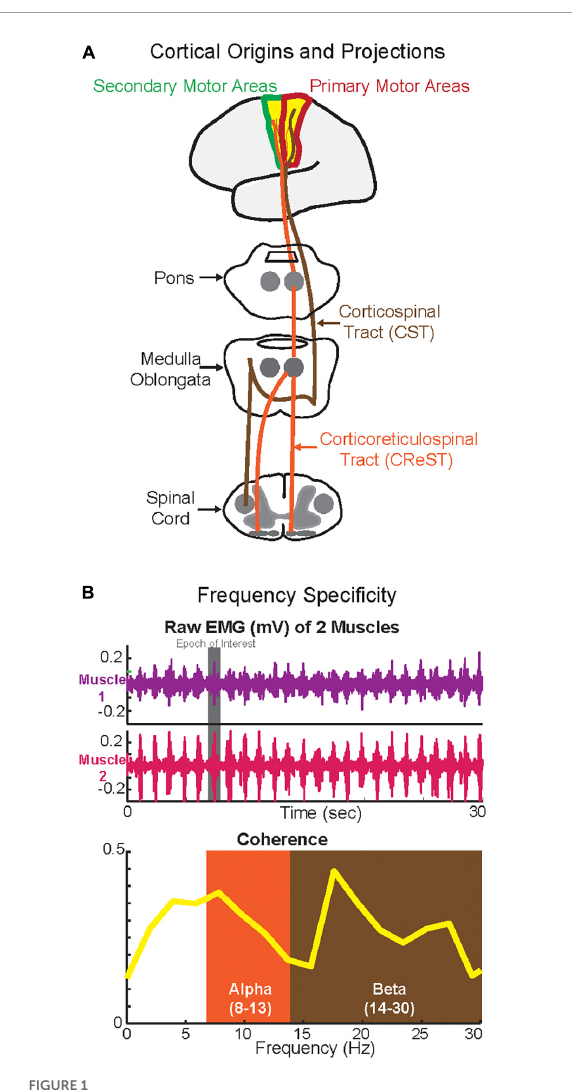
FIGURE1 Cortical origins and the projections of corticospinal tract (CST) and corticoreticulospinal tract (CReST) (A) and frequency specificity (B) . (A) This is a simplified diagram of the origins and projections of the CST and CReST from the cortex to the spinal cord. (B) Top panel depicts phasic activity of two synergistic muscles (e.g., plantarflexors) during walking while the bottom panel depicts the coherence in alpha (putatively CReST-derived) and beta (putatively CST-derived) bands of these two